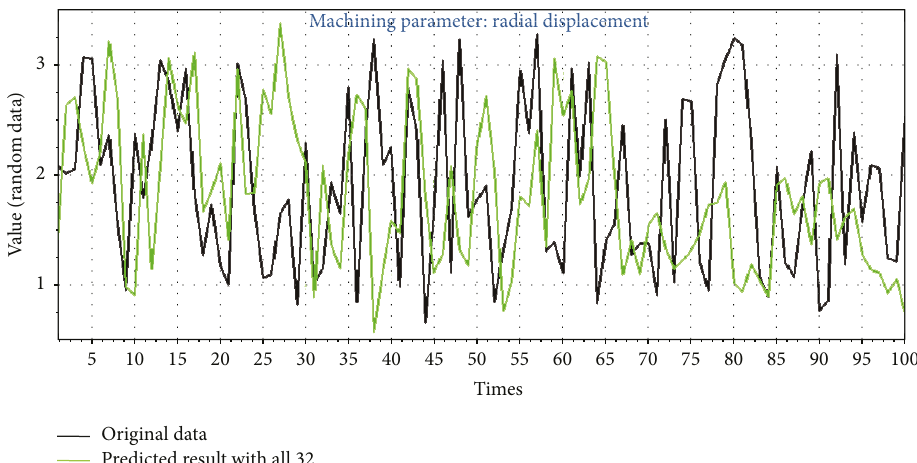
Machining parameter: radial displacementh g